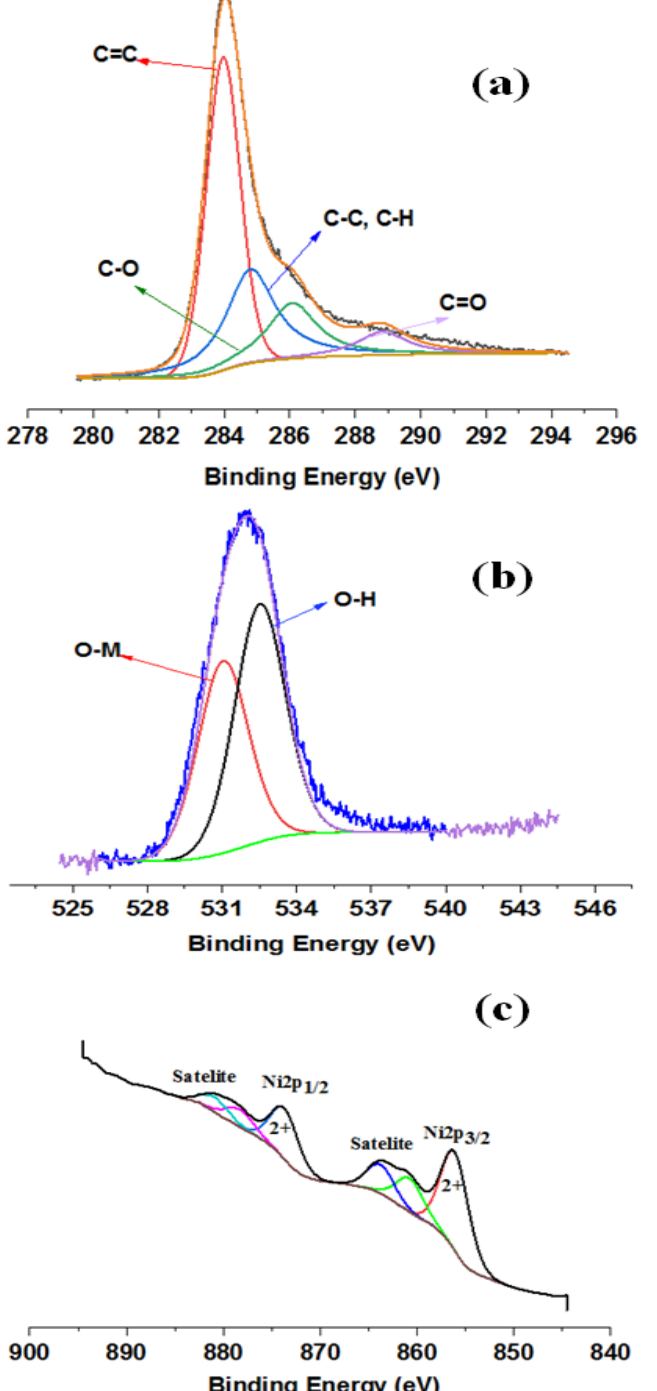
Figure 2. XPS spectra of Ni@CSs composite: C1s ( a ), O1s ( b ), and Ni 2p ( c ).